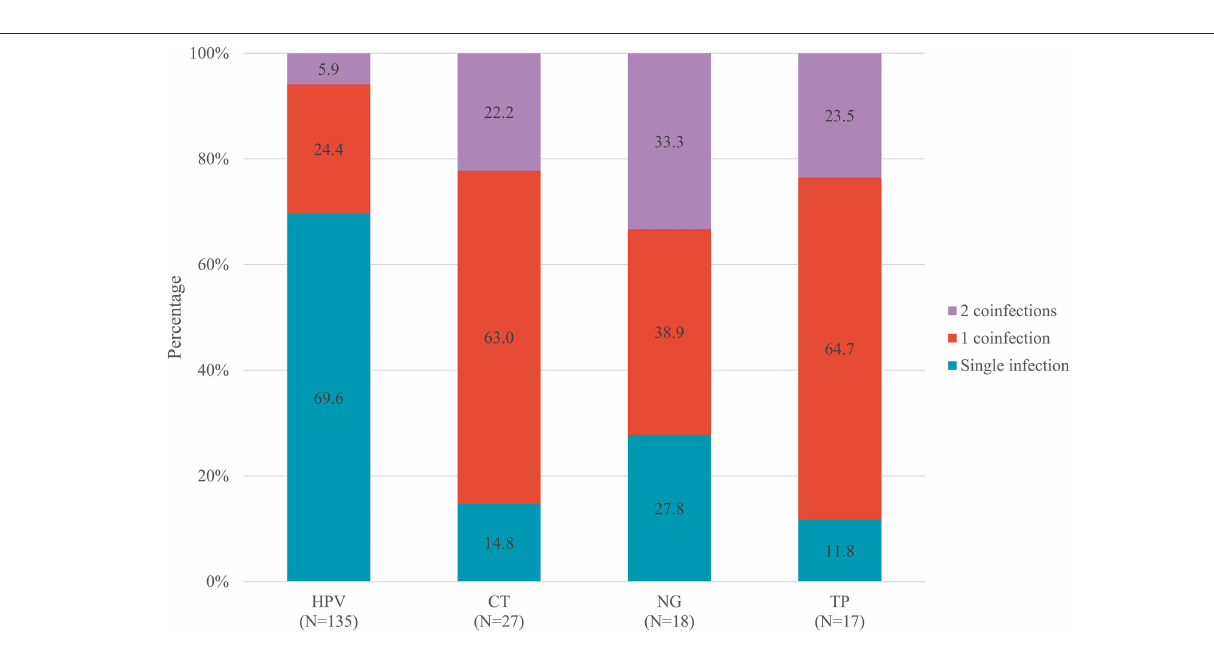
FIGURE 3 | Prevalence of co-infections stratified by HPV, CT, NG, and TP, among 149 MSM with at least one STIs. HPV, human papillomavirus; CT, Chlamydia trachomatis ; NG, Neisseria gonorrhoeae ; TP, Treponema pallidum ; STIs, sexually transmitted infections; MSM, men who have sex with